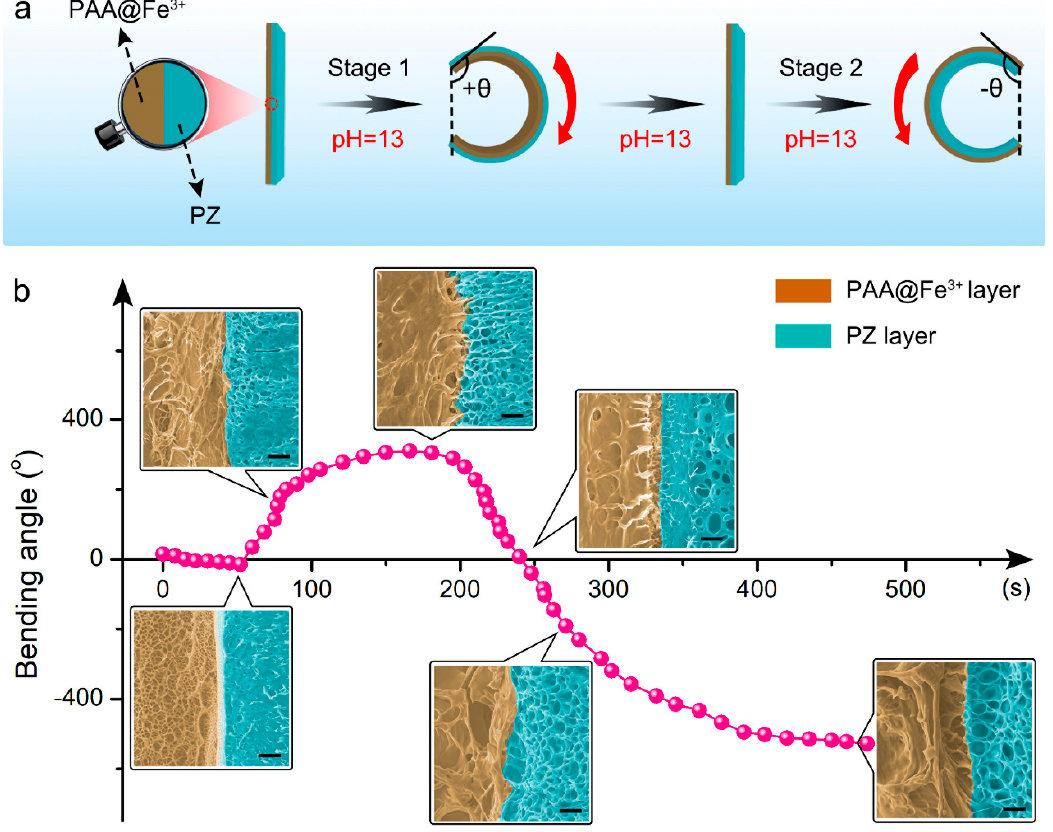
Figure 2. ( a ) Schematic illustration of the shape deformation of PZ-PAA@Fe 3+ bi-layer hydrogel strip. The bi-layer hydrogel at pH = 13 first bent toward the PAA@Fe 3+ side (+), then became straight, and finally bent toward the PZ side ( − ). ( b ) Bending deformation of PZ-PAA@Fe 3+ bi-layer hydrogel at pH = 13 and SEM images of the cross sections at different stages. All scale bars are 50 μ m.